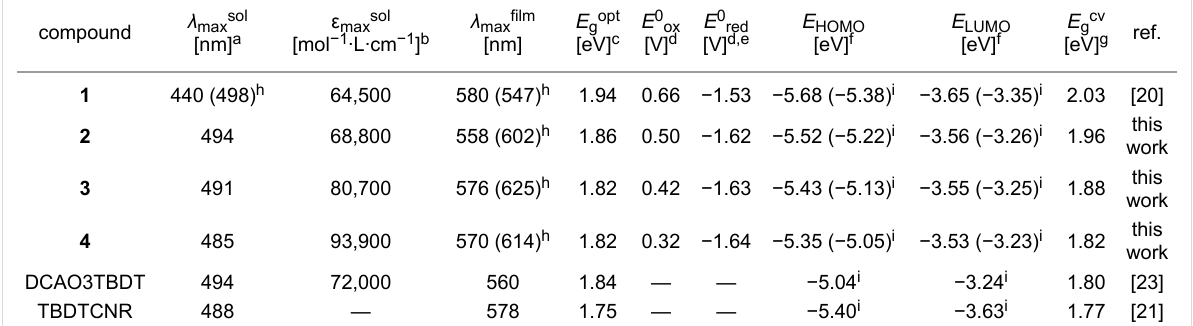
Table 1: Optical and electrochemical properties of 1 – 4 in comparison to other compounds in the literature.